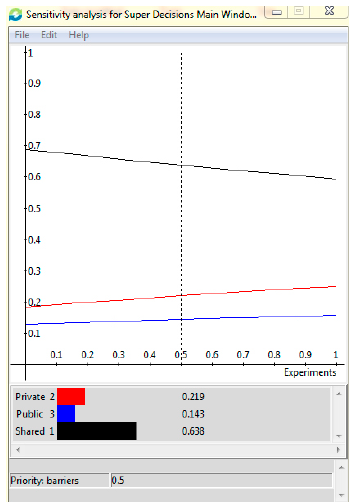
Fig. 6. Sensitivity analysis of the model based on r 18